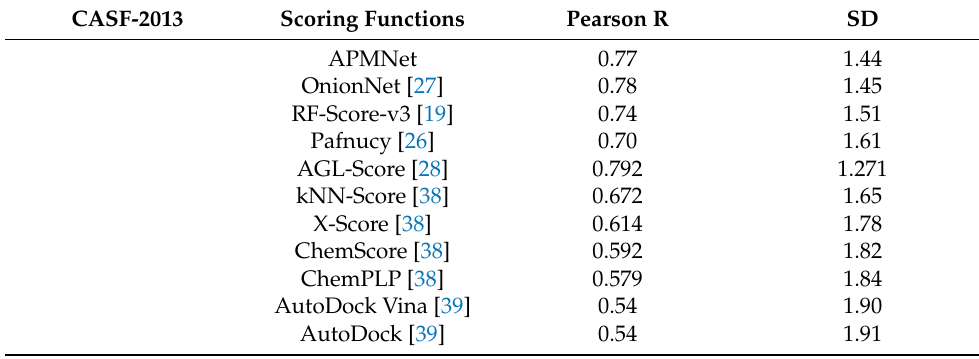
Table 3. Performance comparison of different methods on CASF2013.